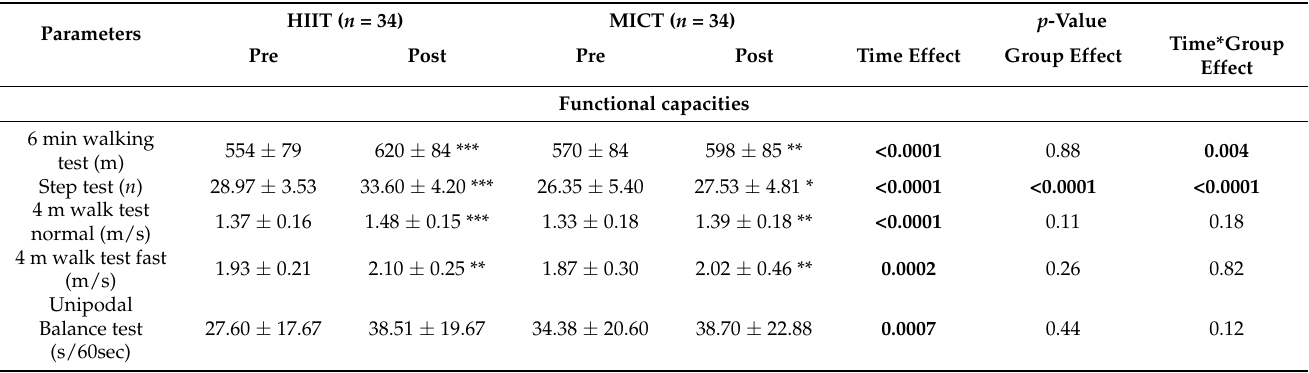
Table 2. Functional capacities and skeletal muscle function in obese older adults following 12 weeks of High-Intensity Interval Training (HIIT) and Moderate-Intensity Continuous Training